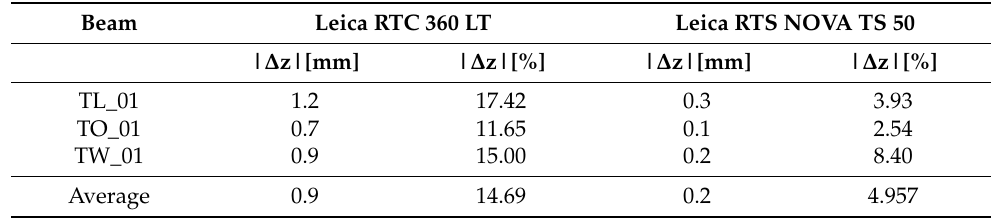
Table 6. Comparison of measurement